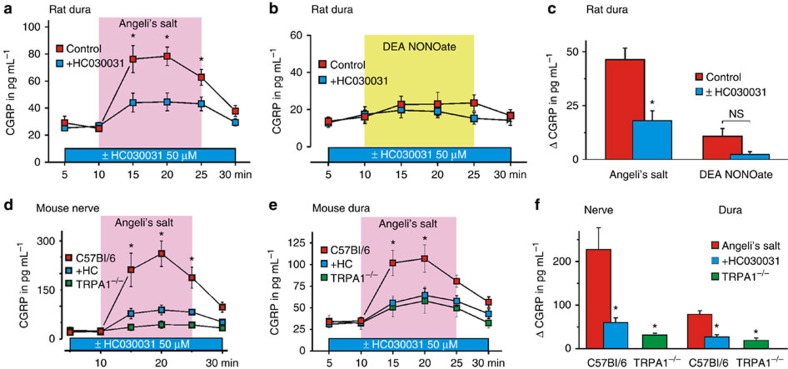
HNO activation of TRPA1 releases CGRP.(a) AS (500 nmol per skull half) reversibly induced CGRP release from rat cranial dura mater, which was diminished by application of HC030031 (Wilcoxon matched pairs tests, *P=0.008, n=9 repeated measures ANOVA and HSD post hoc tests, *P<0.05, n given in the figure). (b,c) DEA NONOate (333 nmol per skull half) did not stimulate CGRP release from rat dura mater encephali, while AS (500 nmol)-induced CGRP release was diminished by application of HC030031 (analysis of variance (ANOVA) honestly significant difference (HSD) post hoc test, *P<0.001, n=9 each). (d) CGRP release from sciatic nerve of C57Bl/6 mice is stimulated by AS (250 nmol). Co-application of HC030031 (50 μM) reduces AS-stimulated CGRP release (U-test, P≤0.02; n=7) while the AS effect is abolished in TRPA1−/− mice. (e) CGRP release from mouse dura mater encephali of C57Bl/6 mice is activated by AS (250 nmol per skull half) and diminished by HC030031 (50 μM) (Wilcoxon matched pairs test, P=0.01 each, n=8); CGRP release is also markedly reduced in preparations of TRPA1−/− mice treated with AS (250 nmol per skull half). (f) Histogram showing the maximal CGRP released from C57Bl/6 and TRPA1−/− mouse sciatic nerve and dura mater upon stimulation with AS. AS effects were reduced by HC030031 (50 μM) and absent in TRPA1−/− (ANOVA HSD post hoc tests, *P≤0.01 compared with AS-treated C57Bl/6; all error bars represent s.e.m.).